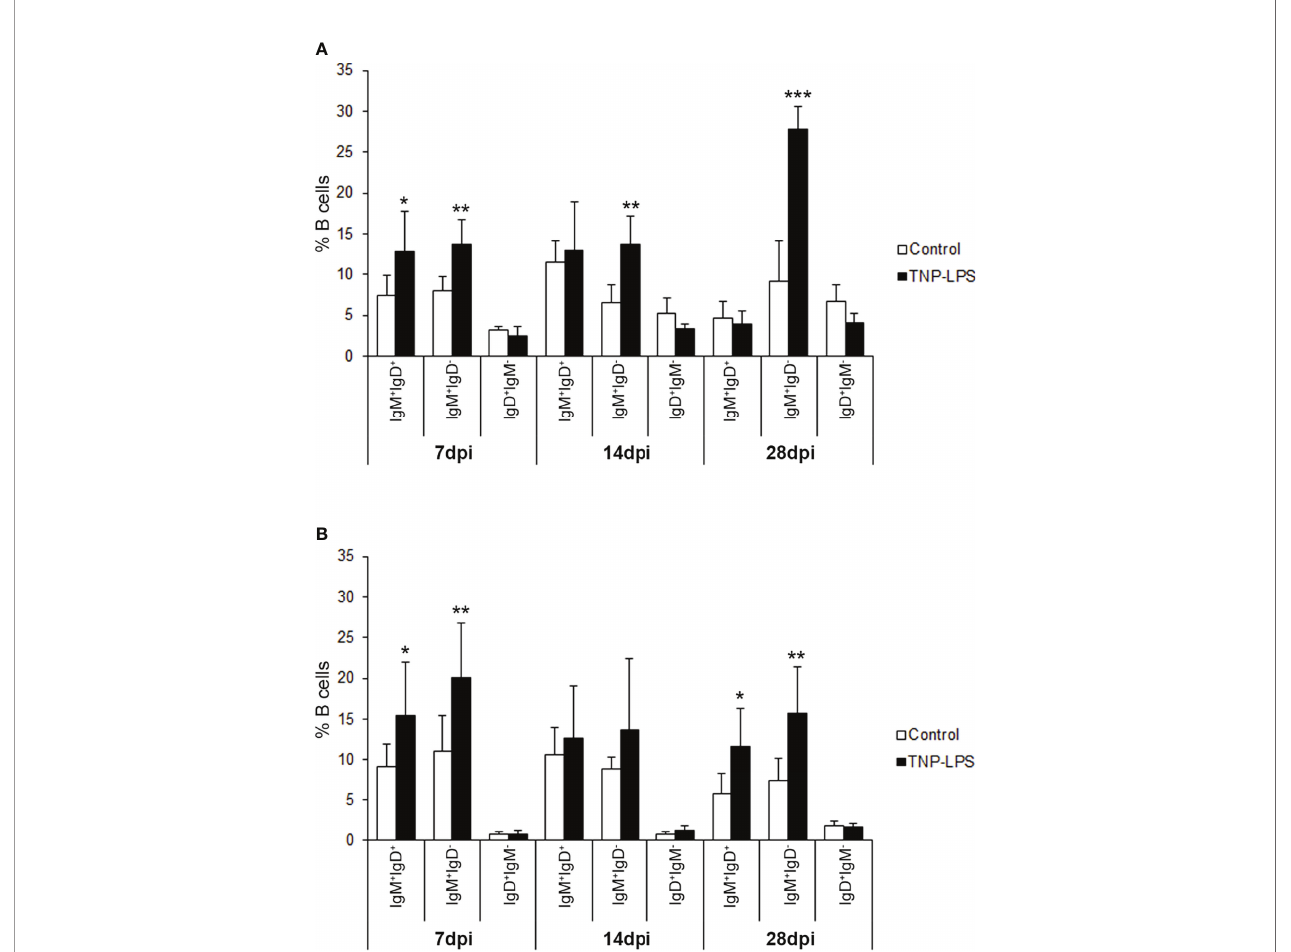
FIGURE 7 | Flow cytometry analysis of the different B cell subpopulations found in the AT and the peritoneal cavity after an intraperitoneal stimulation with TNP-LPS. Isolated AT and peritoneal leukocytes from fi sh immunized intraperitoneally with TNP-LPS and mock immunized (control) were incubated with an anti-trout IgM mAb conjugated to phycoerythrin (PE) and an anti-trout IgD mAb conjugated to allophycocyanin (APC) and analyzed by fl ow cytometry. Graphs show the mean percentage of the three different B cell subpopulations (IgM + IgD + ; IgM + IgD - and IgD + IgM - ) present in the AT (A) and the peritoneal cavity (B) at the three sampling times (7, 14 and 28 days post-immunization) (mean + SD; n = 8). Asterisks denote signi fi cantly different values between the percentages obtained in the immunized group and those of the control group (*p ≤ 0.05 **p ≤ 0.01 and ***p ≤